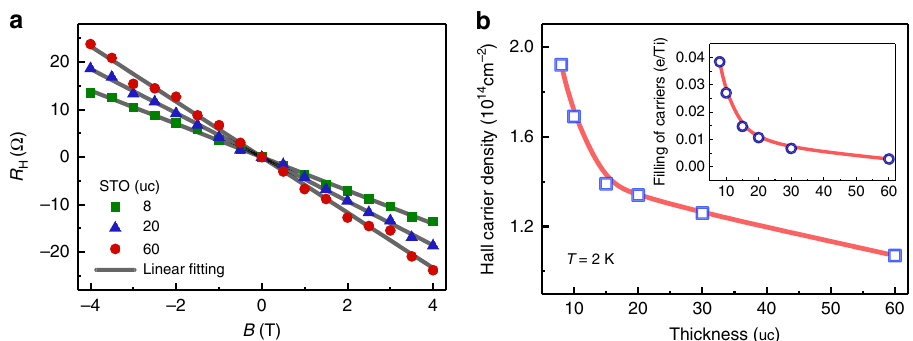
Fig. 3 Carrier density estimation of the LAO//STO/LAO heterostructures. a Hall effect data measured at 2 K for the LAO//STO/LAO heterostructure with 8, 20, and 60 uc STO layers along with the linear fi tting. b STO thickness-dependent Hall carrier density, from which the fi lling of electrons per Ti is calculated (inset). The solid lines are guides to